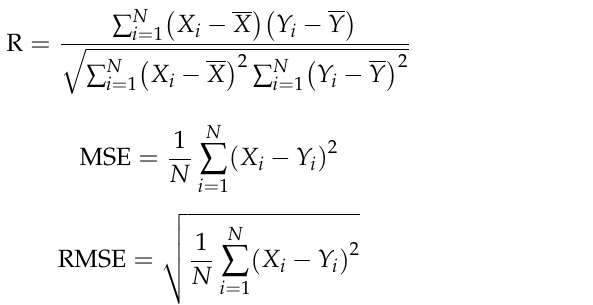
( c ) Figure 8. Predicted energy consumption for the low-consumption profile in regression format: ( a ) 2016 – 2017; ( b ) 2018; ( c ) 2019 – 2020.